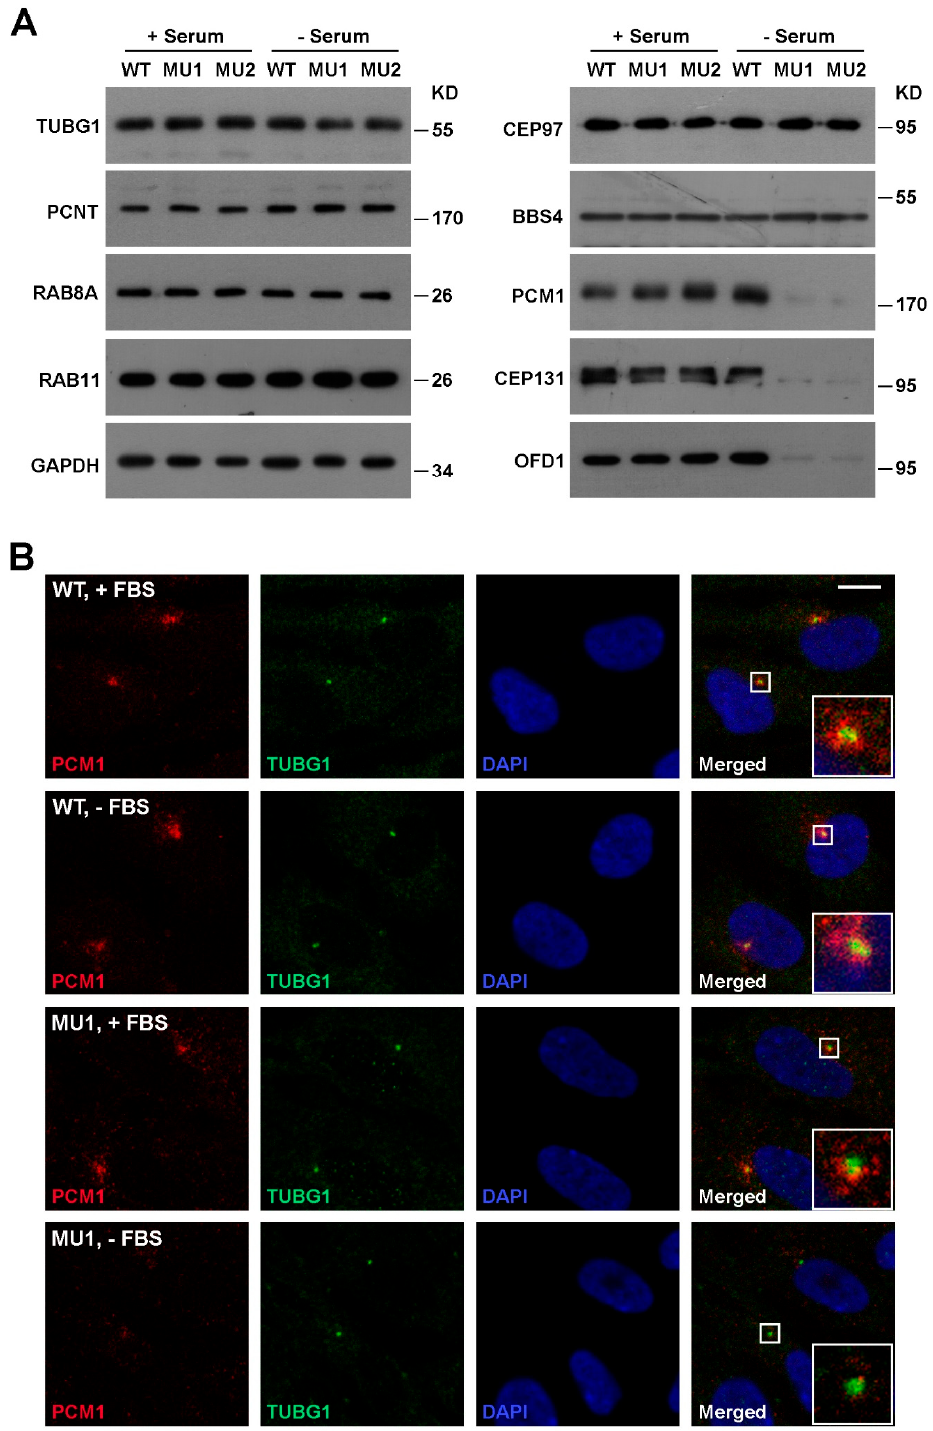
Figure 3. SNX17 deficiency induces degradation of multiple centriolar satellite proteins. ( A ) Western blot analysis of the indicated proteins in total cell lysate of WT or SNX17 mutant cells. Cells were cultured in either serum-containing or serum-free condition for 48 h, and then harvested for analysis. Gamma-tubulin (TUBG1), PCNT, and CEP97 are centrosome proteins. RAB8A and RAB11 are RAB family vesicular tra ffi cking proteins involved in ciliogenesis. BBS4 is a member of the BBSsome complex that regulates the ciliary entry of RABs. PCM1, CEP131, and OFD1 are centriolar satellite proteins involved in ciliogenesis. ( B ) Distributions of PCM1 and TUBG1 in WT and mutant cells in the presence or absence of serum for 48 h. Scale bar, 10 µ